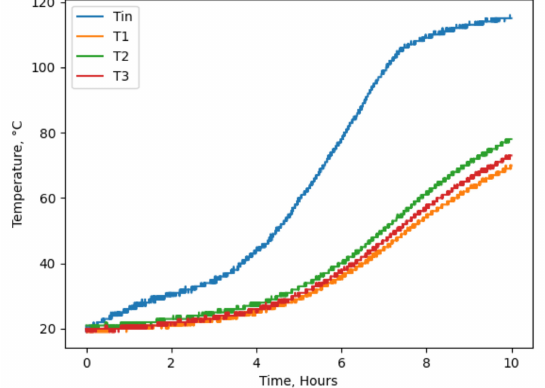
Figure 3. Startup scenario and first heating ramp for the first 10 h, GEO sample. T 1 ,T 2 , and T 3 are thermocouples shown in Figure 1. T in is the HTF (air) inlet